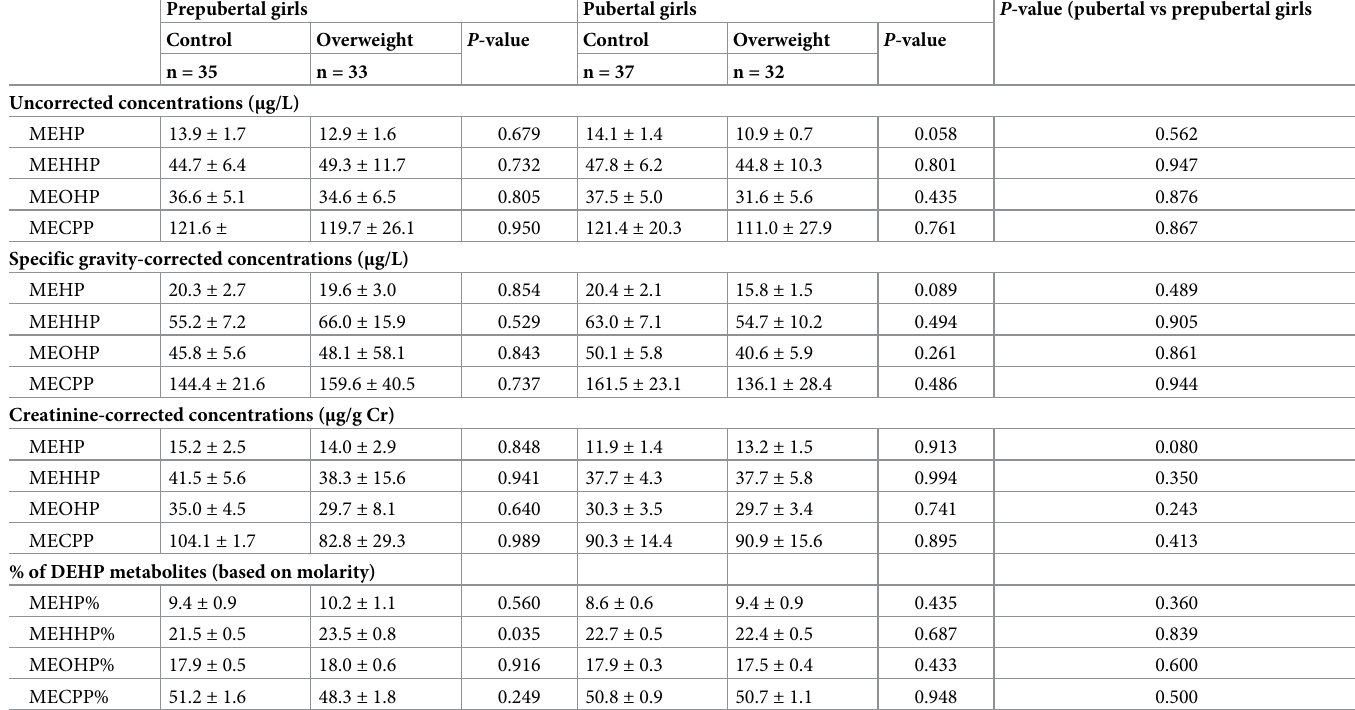
RRMs of the DEHP metabolites were stratified by the obesity and puberty status (S1 Table). A significantly lower RRM2 was found in the overweight girls than in the controls, but only for the prepubertal girls. No significant differences were found in RRM1 and RRM2, regardless of obesity and puberty status. Table 3. Geometric means ( ± standard error) of urinary phthalate metabolite concentrations and percentage fractions of di(2-ethylhexyl) phthalate (DEHP) metab- olites by obesity and puberty status. Prepubertal